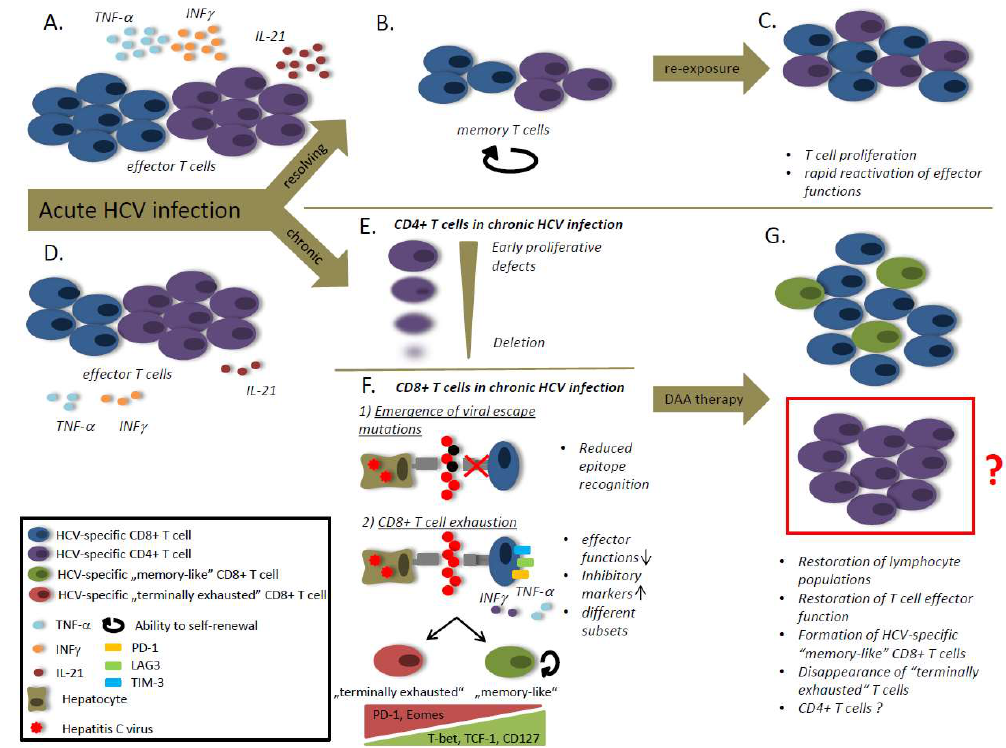
Figure 1. The role of the hepatitis C virus (HCV)-specific T cells in HCV infection. ( A ) Viral clearance is associated with strong T helper and cytotoxic T lymphocyte responses and high levels of IL-21. ( B ) After viral clearance the effector cell population decay and the T cells differentiate into a memory population with the ability to self-renewal. ( C ) The memory T cells are able to rapidly reactivate effector functions and to proliferate in case of antigen re-stimulation. ( D ) Viral persistence is associated with a reduced CD8 T cell frequency and weaker T cell responses compared to patients that spontaneously clear the virus. ( E ) During chronic HCV infection CD4 T cells exhibit early proliferative defects followed by a CD4 T cell deletion. ( F ) CD8 T cell responses are impaired during chronic HCV infection due to viral escape mutations and T cell exhaustion. Viral escape mutations cause reduced epitope recognition by CD8 T cells. T cell exhaustion is caused by an ongoing antigen-stimulation and characterized by a loss of effector functions and an increased expression of inhibitory markers. Different subsets of exhausted T cells have been defined. “Memory-like” CD8 T cells are characterized by high expression of T-bet, transcription factor T-cell factor 1 (TCF-1) and CD127, whereas “terminally exhausted” CD8 T cells express high levels of PD-1 and Eomes. ( G ) After therapy with direct acting antivirals (DAAs) a lymphocyte proliferation can be observed, accompanied by the restoration of effector functions. After DAA treatment “memory-like” CD8 T cells are detectable, but terminally exhausted CD8 T cells disappear. The role of CD4 T cells after therapy with DAAs is still